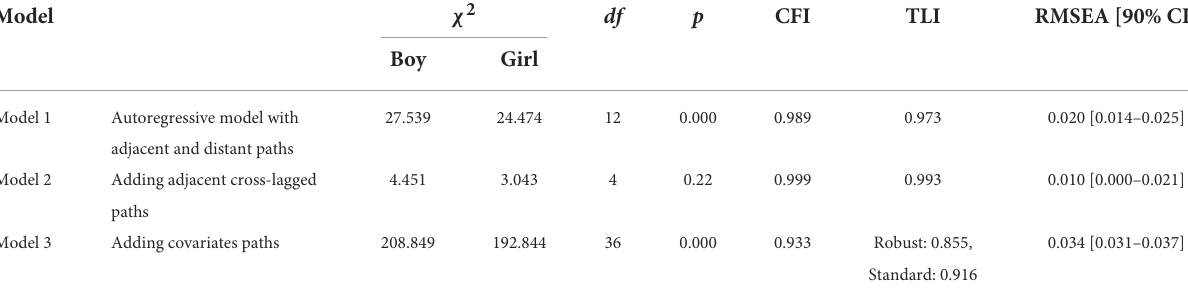
TABLE 5 Models of the reciprocal relations between PA and SDQ-H/I.